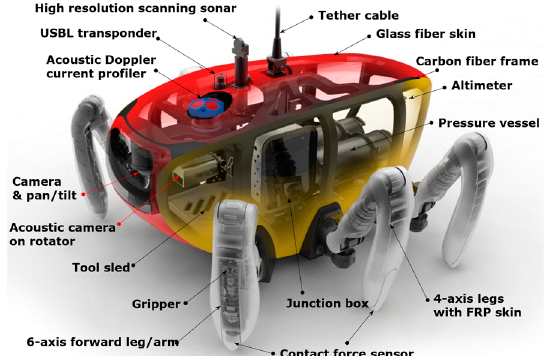
Figure 9. Equipment configuration of CR200.